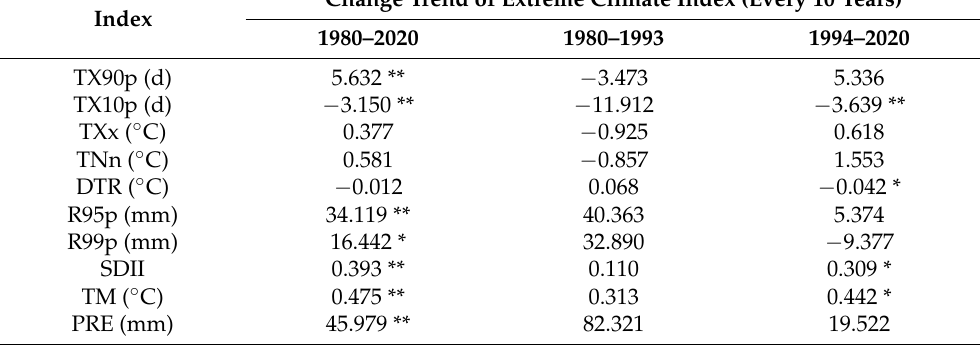
Table 2. Trends of regional average climate extreme variables in the region of Urumqi Glacier